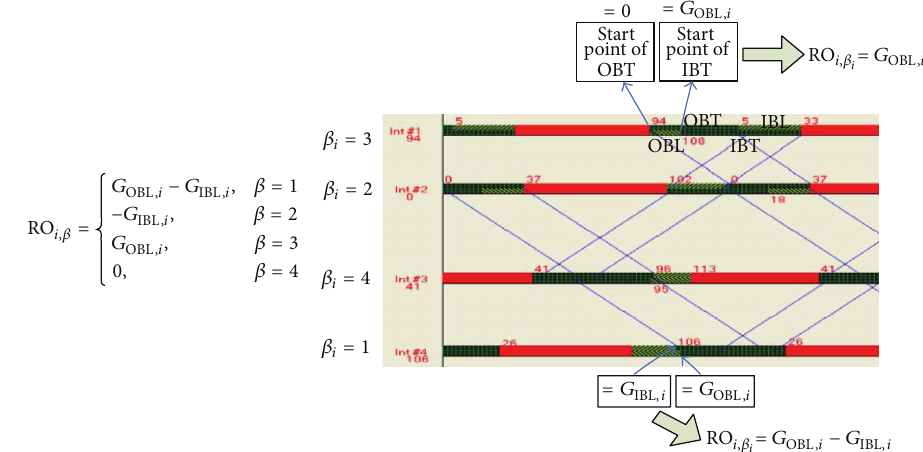
Figure 1: Relative offset of 𝐺